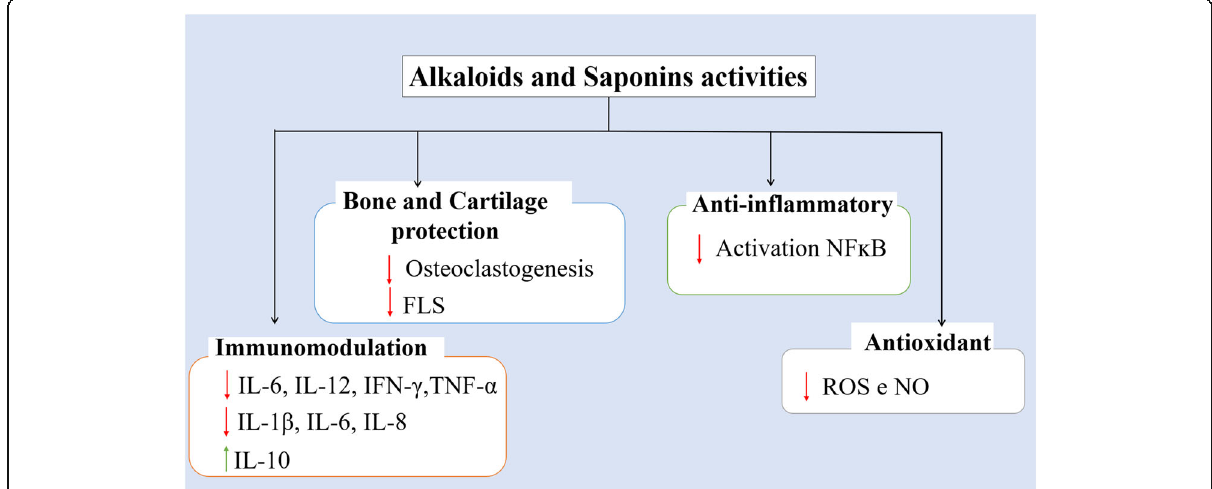
Fig. 2 Biological activities of alkaloids and saponins in RA. Legends: FLS- fibroblast-like synoviocytes, NFkB - nuclear factor ĸ B, IL- interleukin, IFN - interferon, TNF - tumor necrosis factor, ROS - reactive oxygen species and NO - nitric